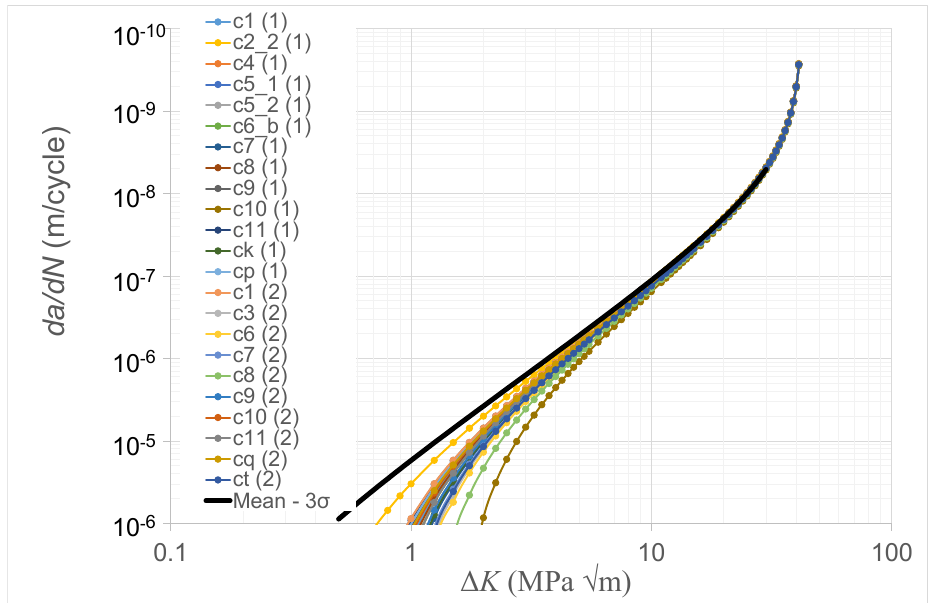
Figure 4. Variability in the crack growth curves for the twenty-three small surface breaking cracks in 7050-T7451 specimens [16]. The labelling convention used for these twenty-three cracks is taken from [16].